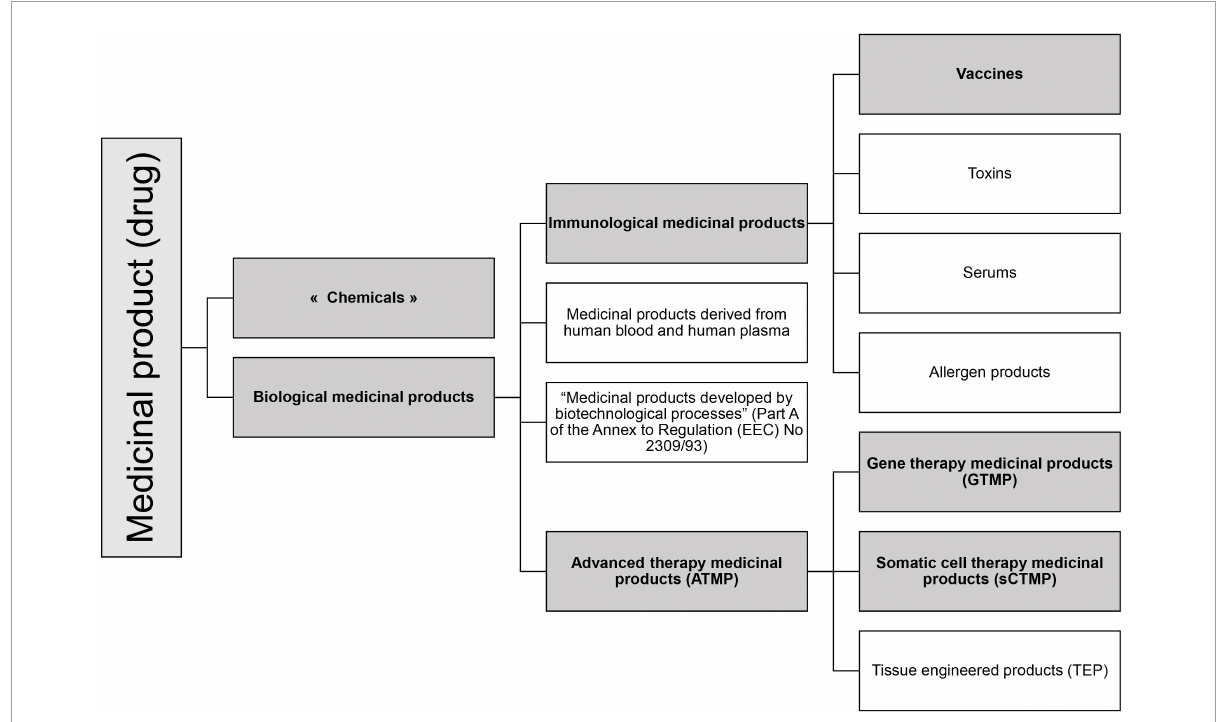
FIGURE1 Medicinal product statuses according to EU legislation. In gray are represented the statuses in which RNA-based drugs can be categorized.